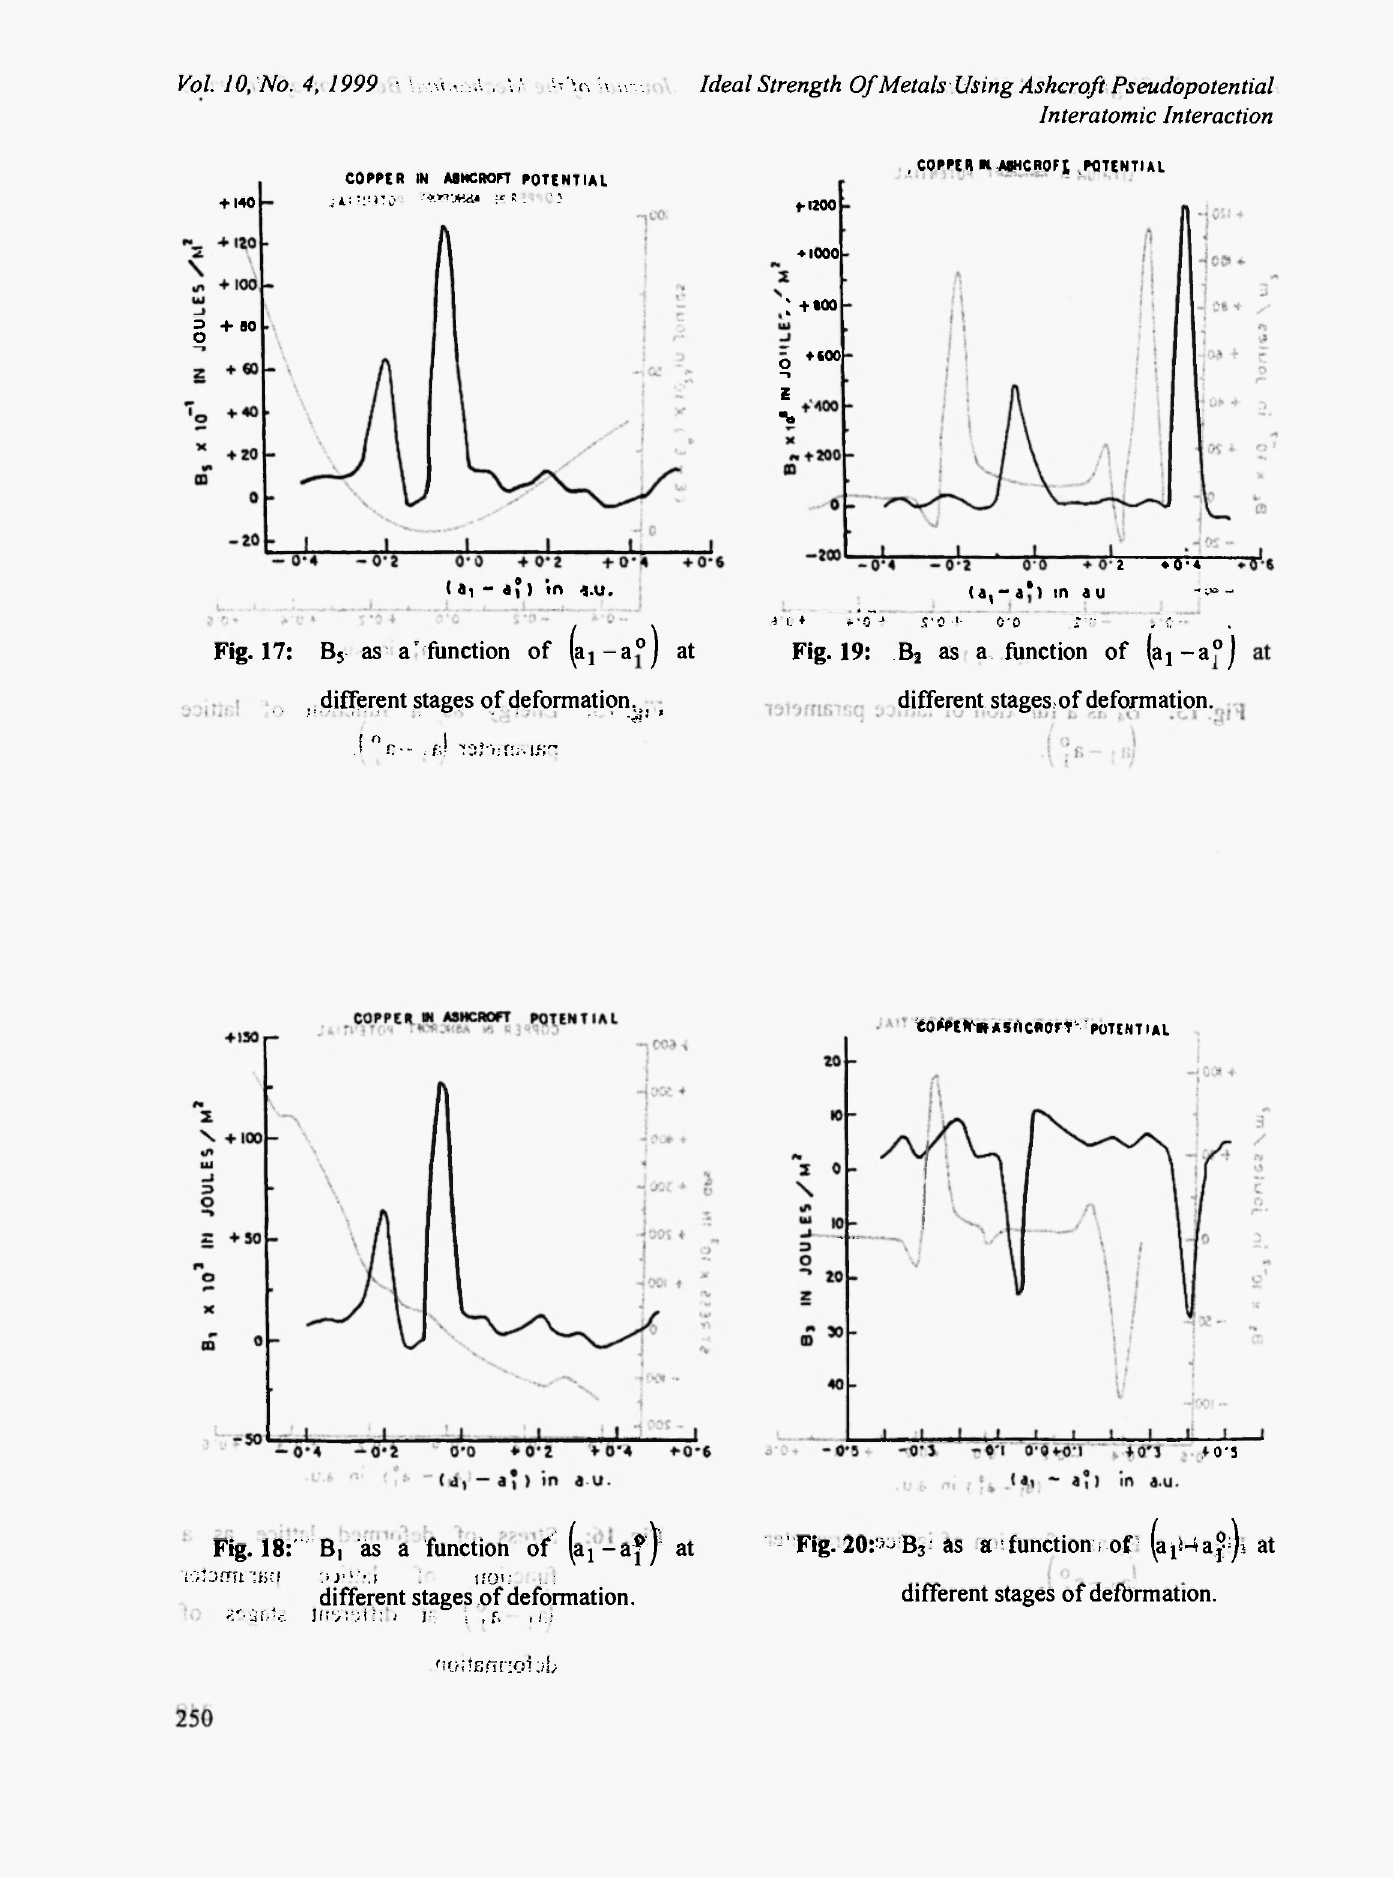
Fig. 18: B, äs a function of (ai - a f) at ' Fig. 20: B 3 as a function of (ajMaf^i at i3tomr-.ijti